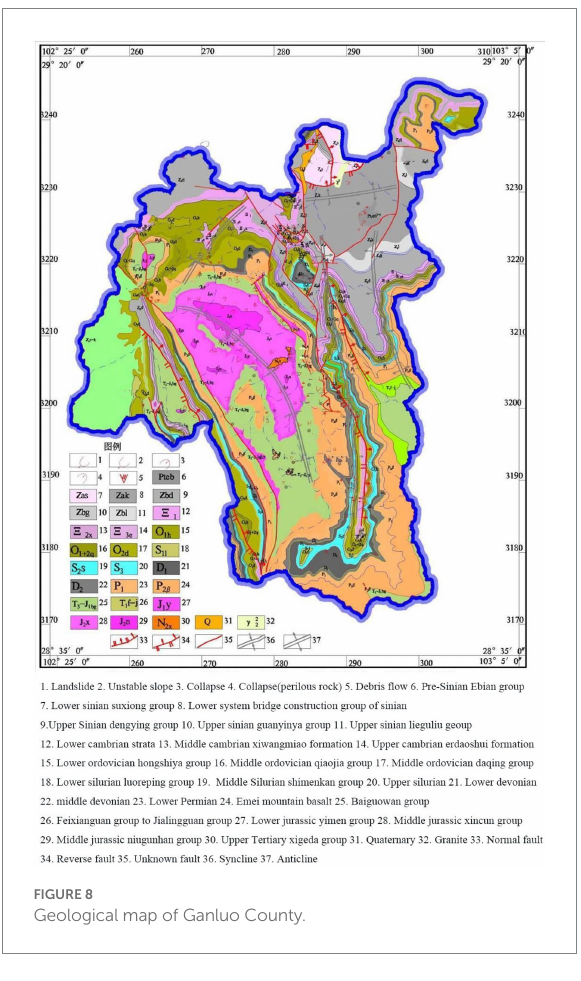
FIGURE 8 Geological map of Ganluo County.